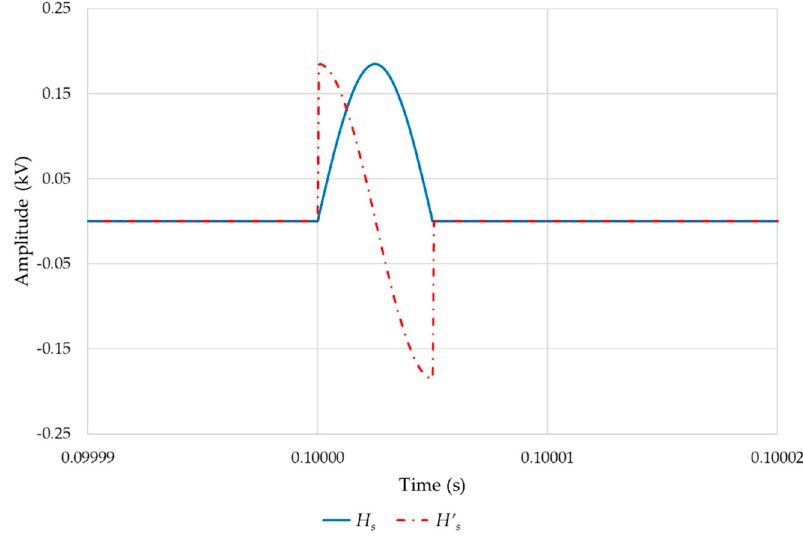
Figure 9. H s and its normalized derivative H (cid:48) s .